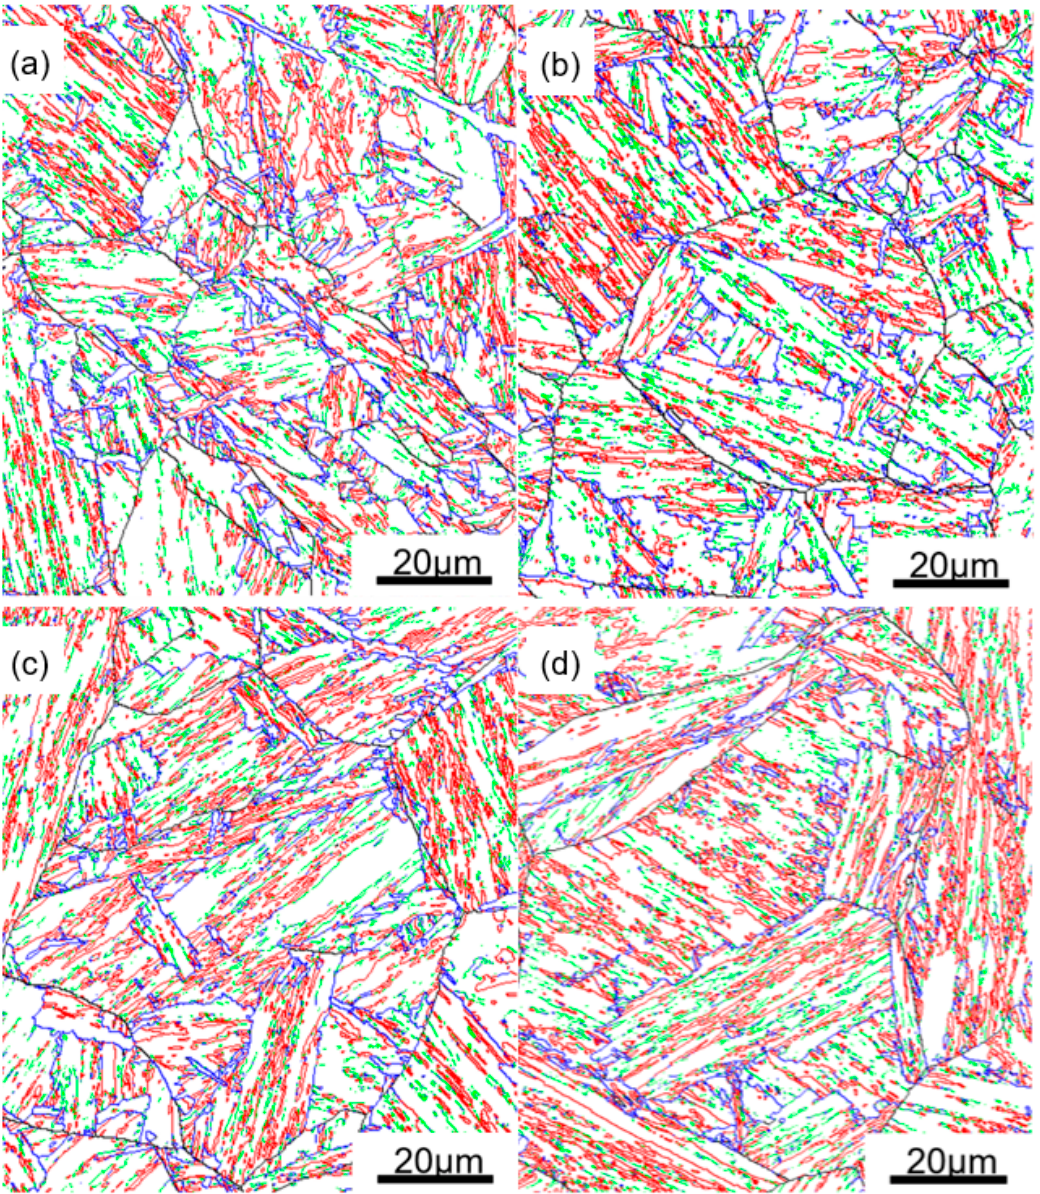
Figure 9. Different types of boundaries (black lines: PAGBs, blue lines: packet boundaries, red lines: block boundaries, green lines: sub-block boundaries) of: ( a ) A880; ( b ) A930; ( c ) A1050; and ( d ) A1100.